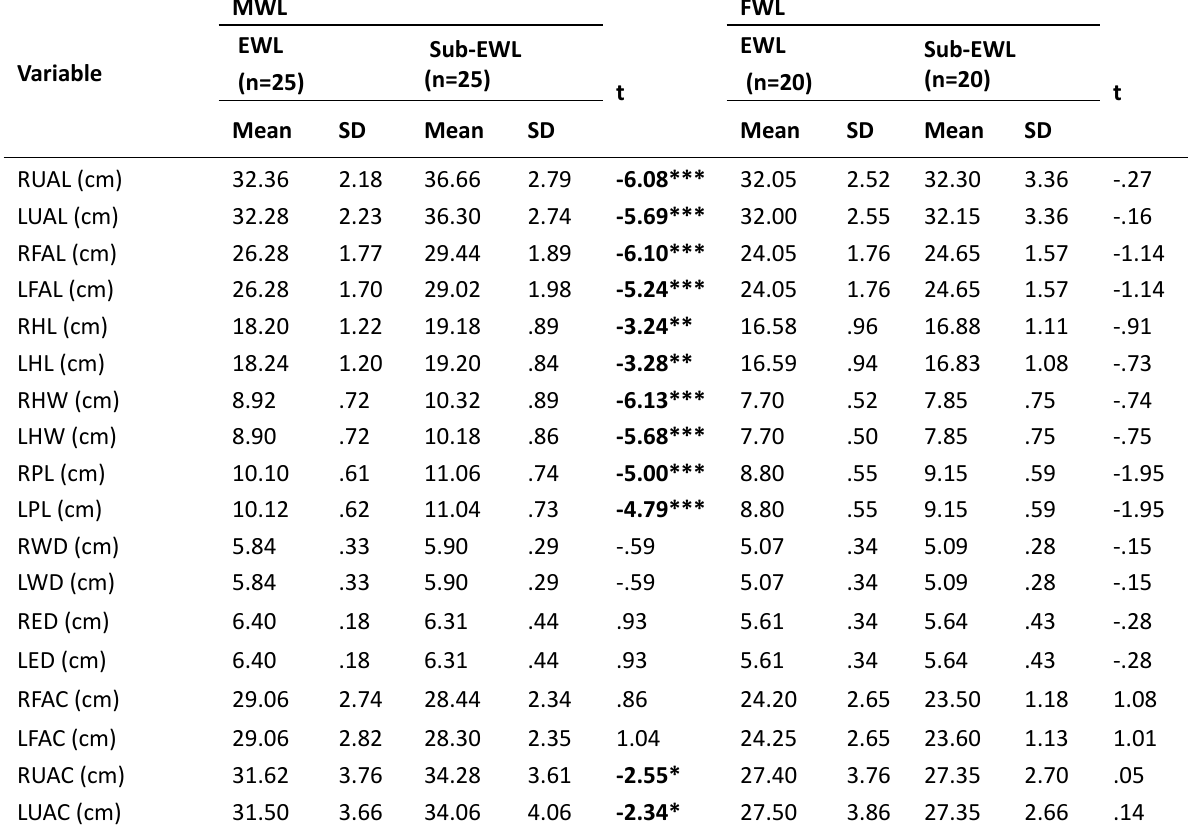
Table 2. Some anthropometric characteristics of upper extremity of Olympic style weightlifting athletes. (Mean ± SD).